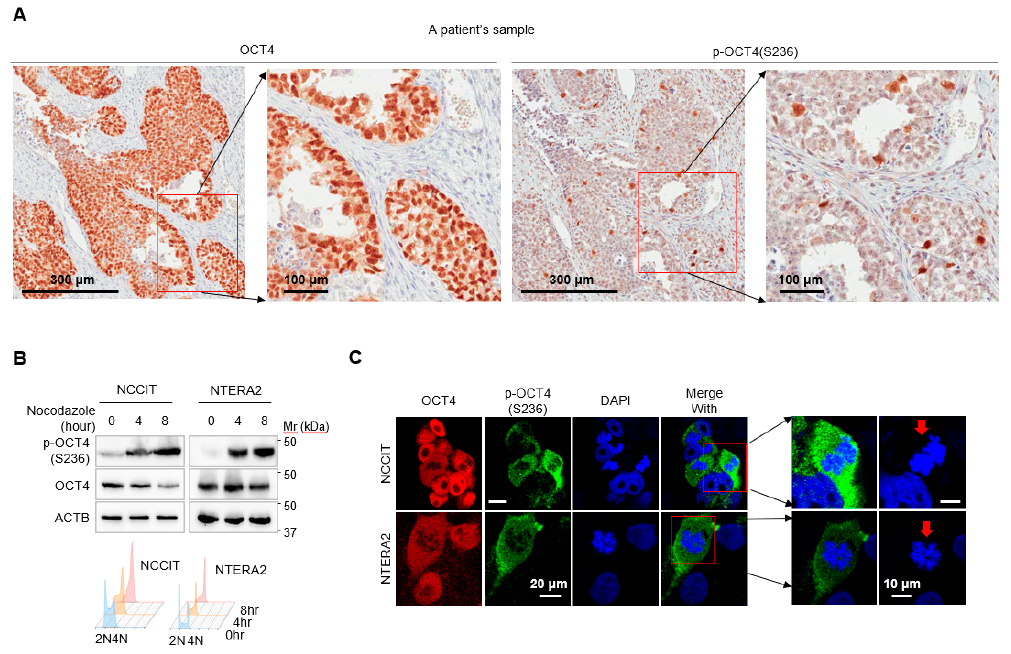
Figure 1. Octamer-binding transcription factor 4 (OCT4) is phosphorylated at S236 in a cell cycle-dependent manner in human cancer cells. ( A ) Immunohistochemistry of a GCT patient sample by the indicated antibodies. p-OCT4 (S236): phosphorylated OCT4 at S236. ( B ) NCCIT and NTERA-2 cells were stained with propidium iodide after treatment with nocodazole (50 ng / mL) for the indicated times. The levels of OCT4 and p-OCT4 (S236) were determined by Western blot (Top). Simultaneously, the DNA contents of individual cells were analyzed by flow cytometry (FACSVerse; BD Biosciences). Histogram images were obtained with FlowJo software (bottom). ( C ) NCCIT and NTERA-2 cells were immunostained with the indicated antibodies. Confocal images were obtained using an LSM 510 confocal microscope (Carl Zeiss). On the right side, larger images for cells with condensed chromatin (arrows) were